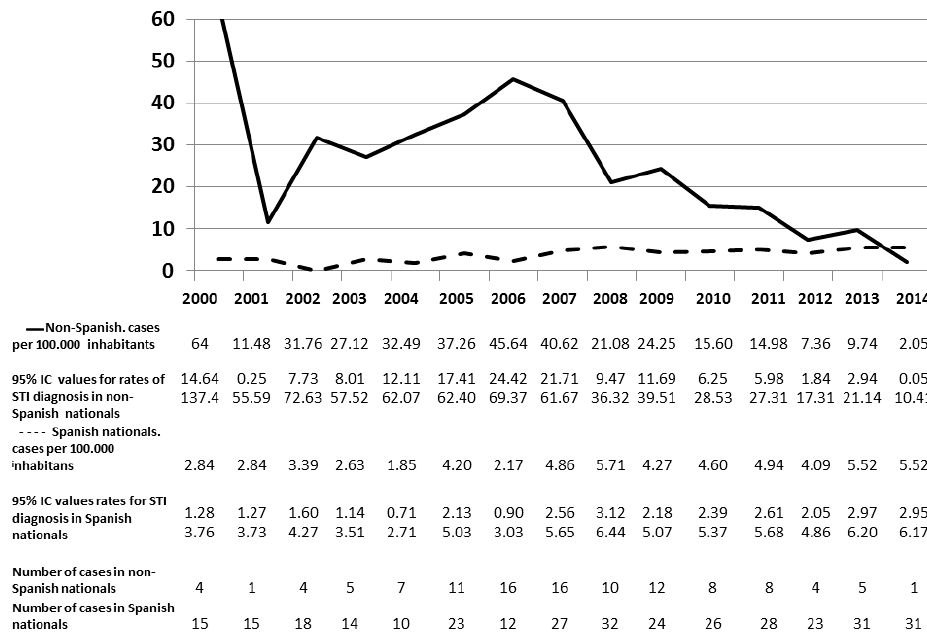
Figure 1. Annual distribution of STI rates for Spanish nationals and non-Spanish nationals aged between 15 and 64 years old. Granada, 2000–2014. STIs: sexually transmitted infections. CI: confidence interval.